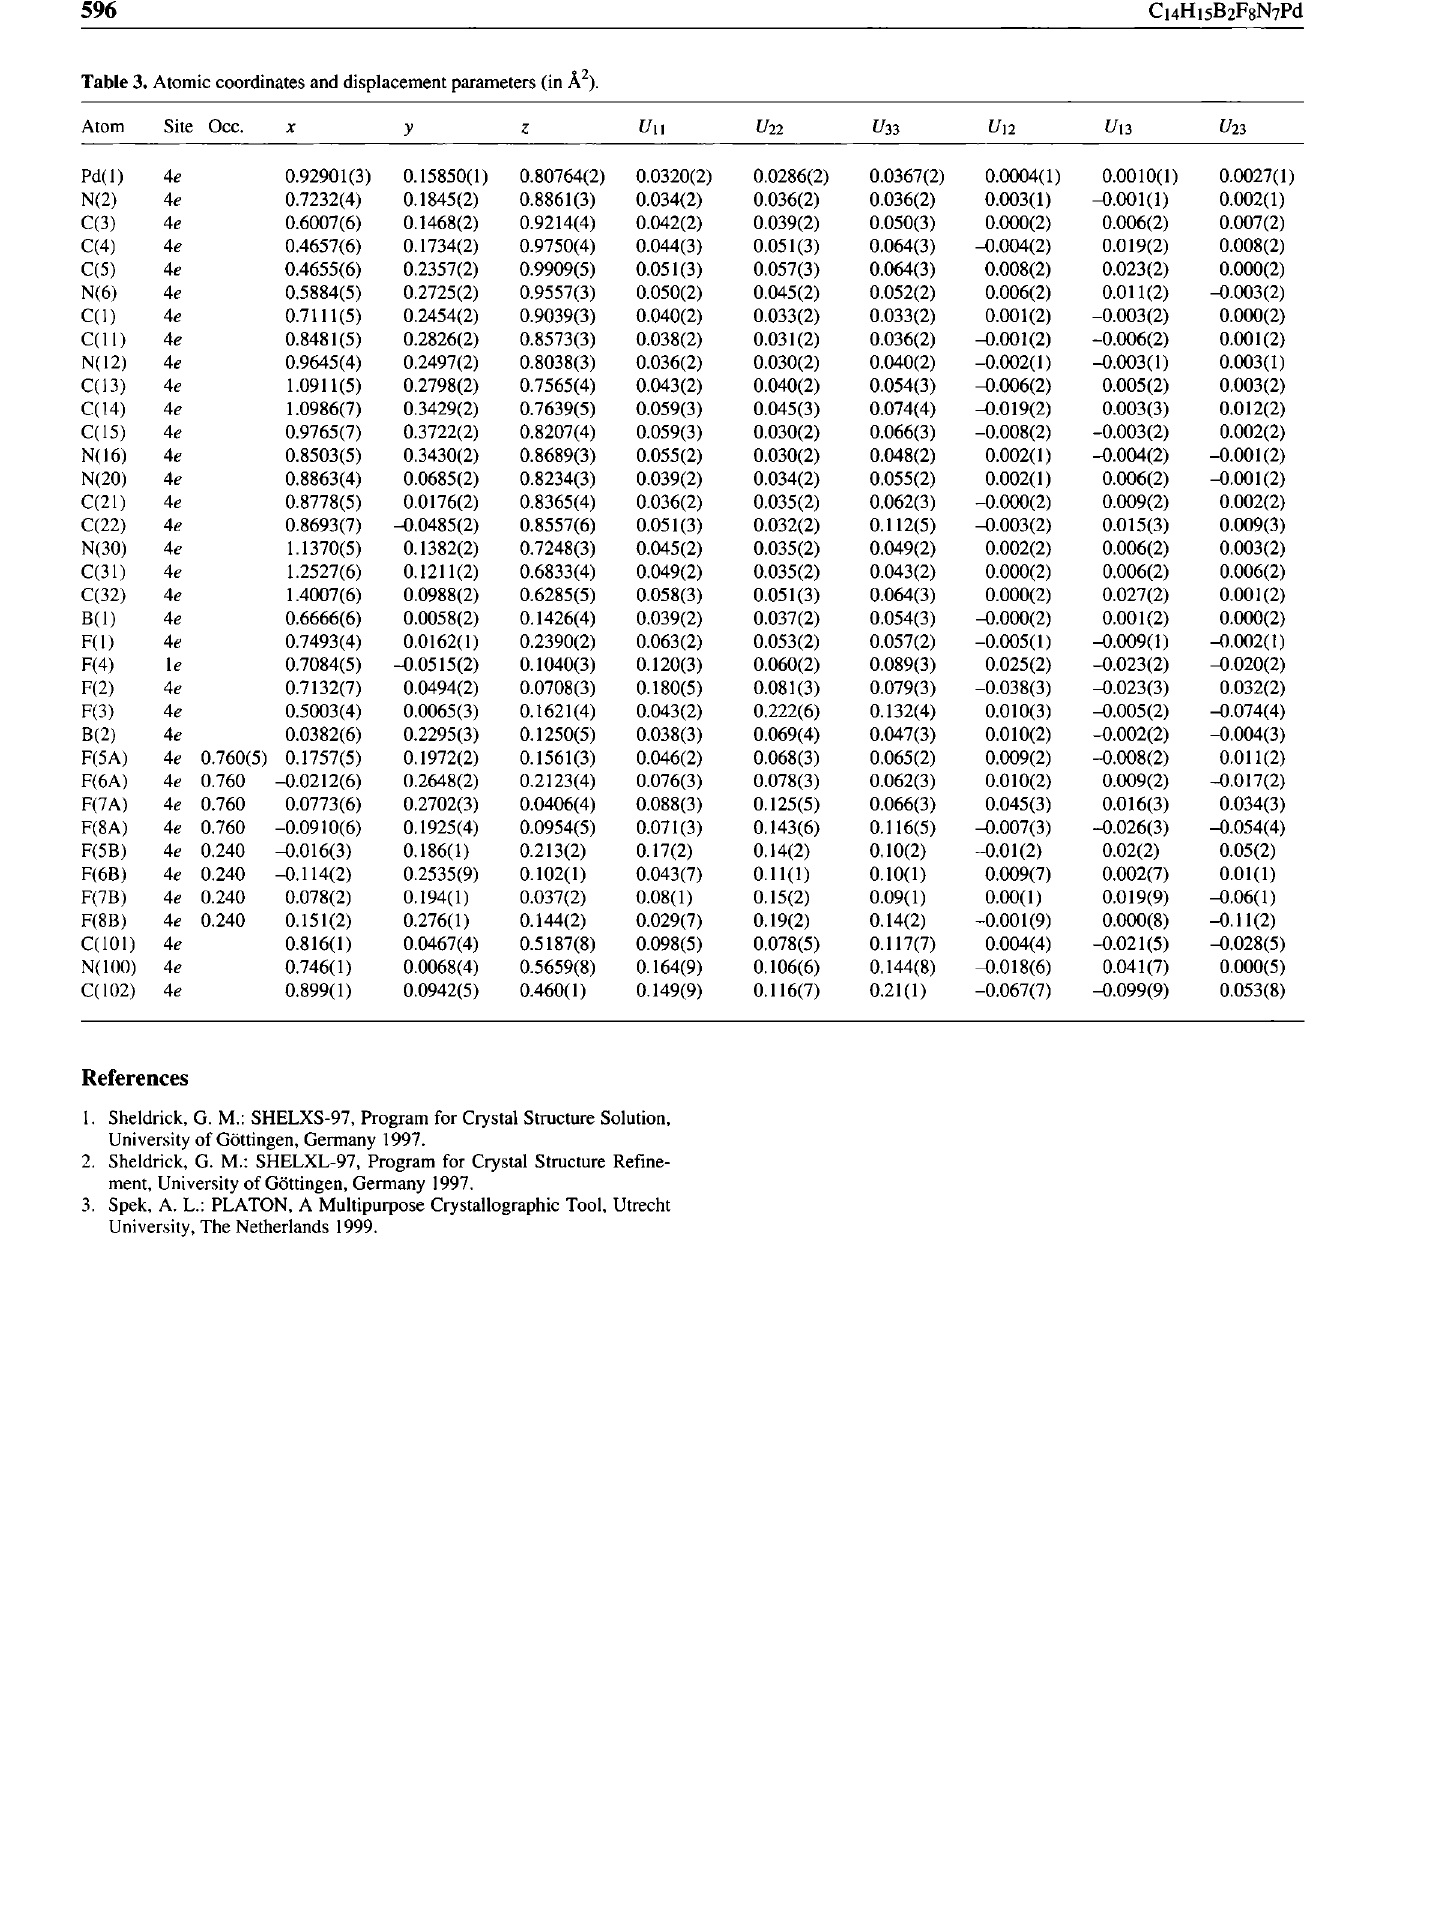
Table 3. Atomic coordinates and displacement parameters (in A 2 ). Atom Site